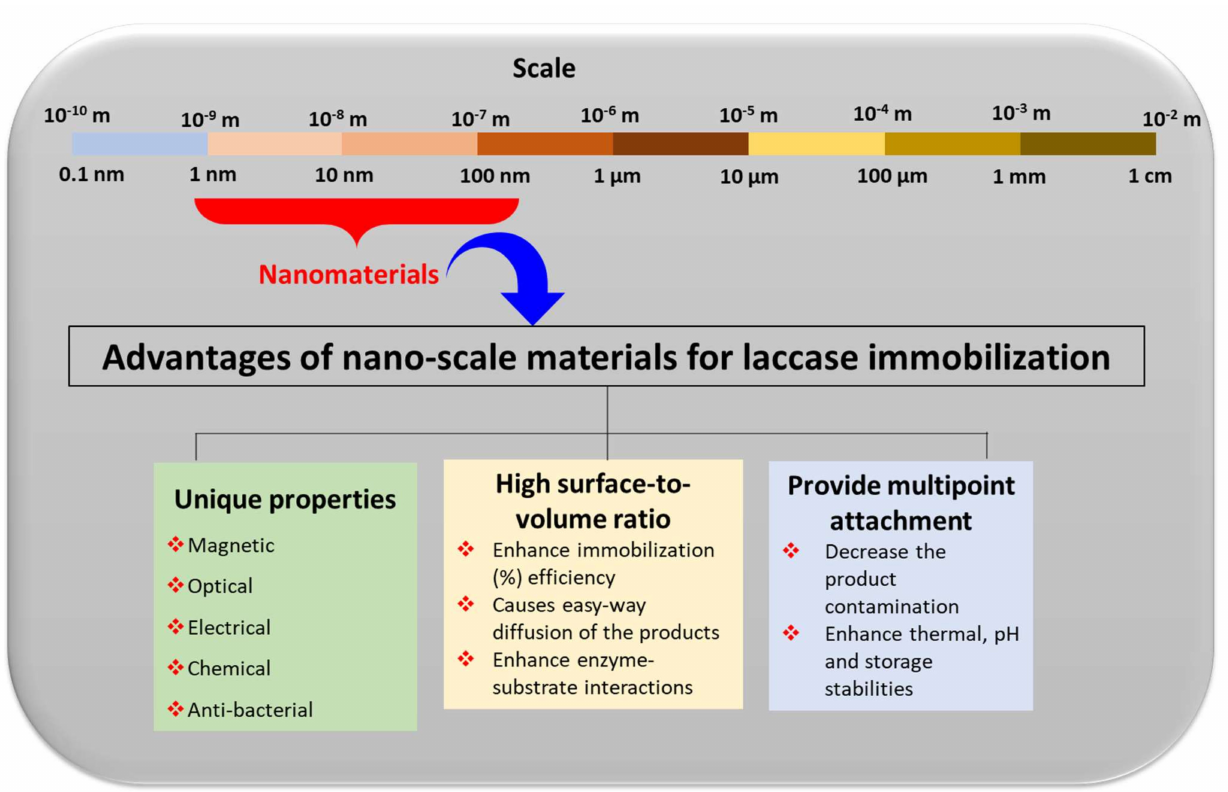
Figure 5. Schematic presentation of the advantages of the nanoscale materials for the laccase immobi- lization